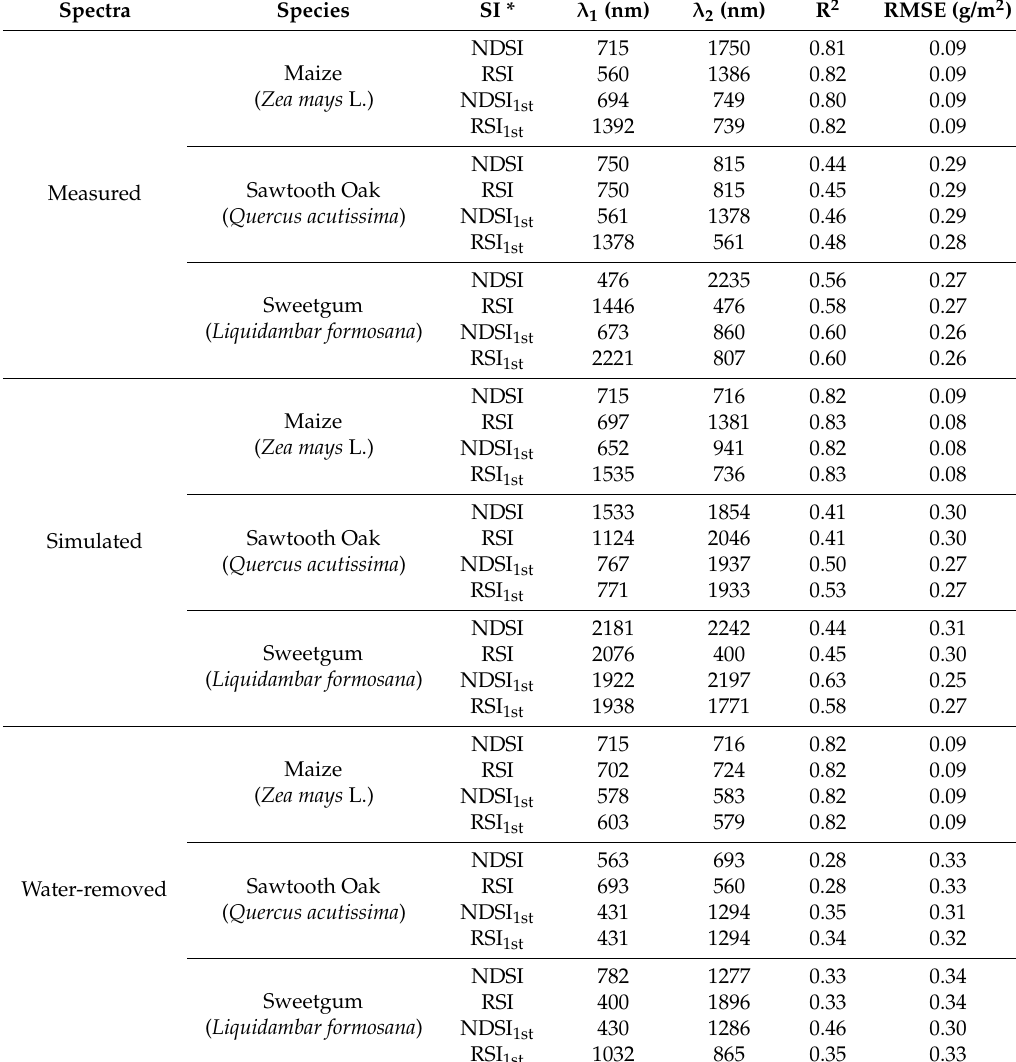
Table 2. Statistics of the species-specific optimal spectral